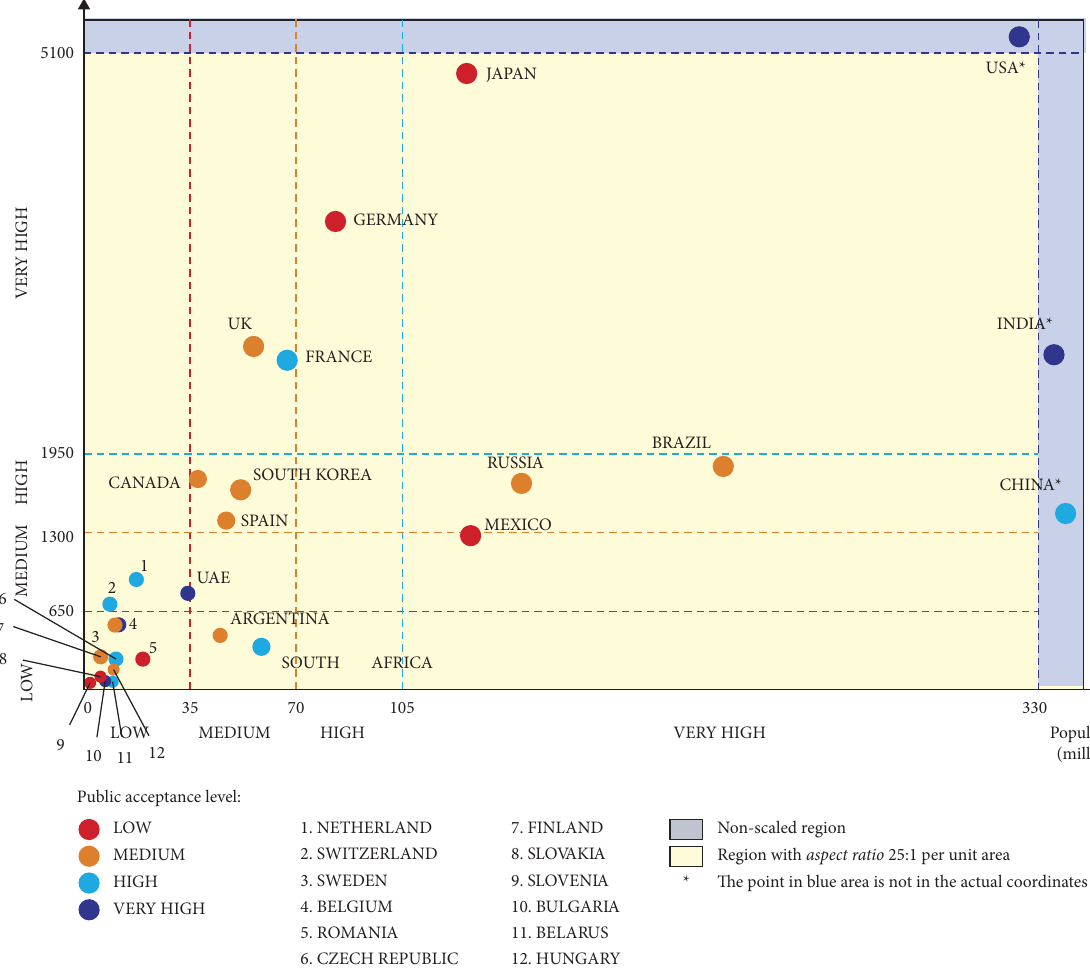
areaNon-scaled region coordinatesRegion with aspect ratio 25:1 per unit The point in blue area is not in the actual